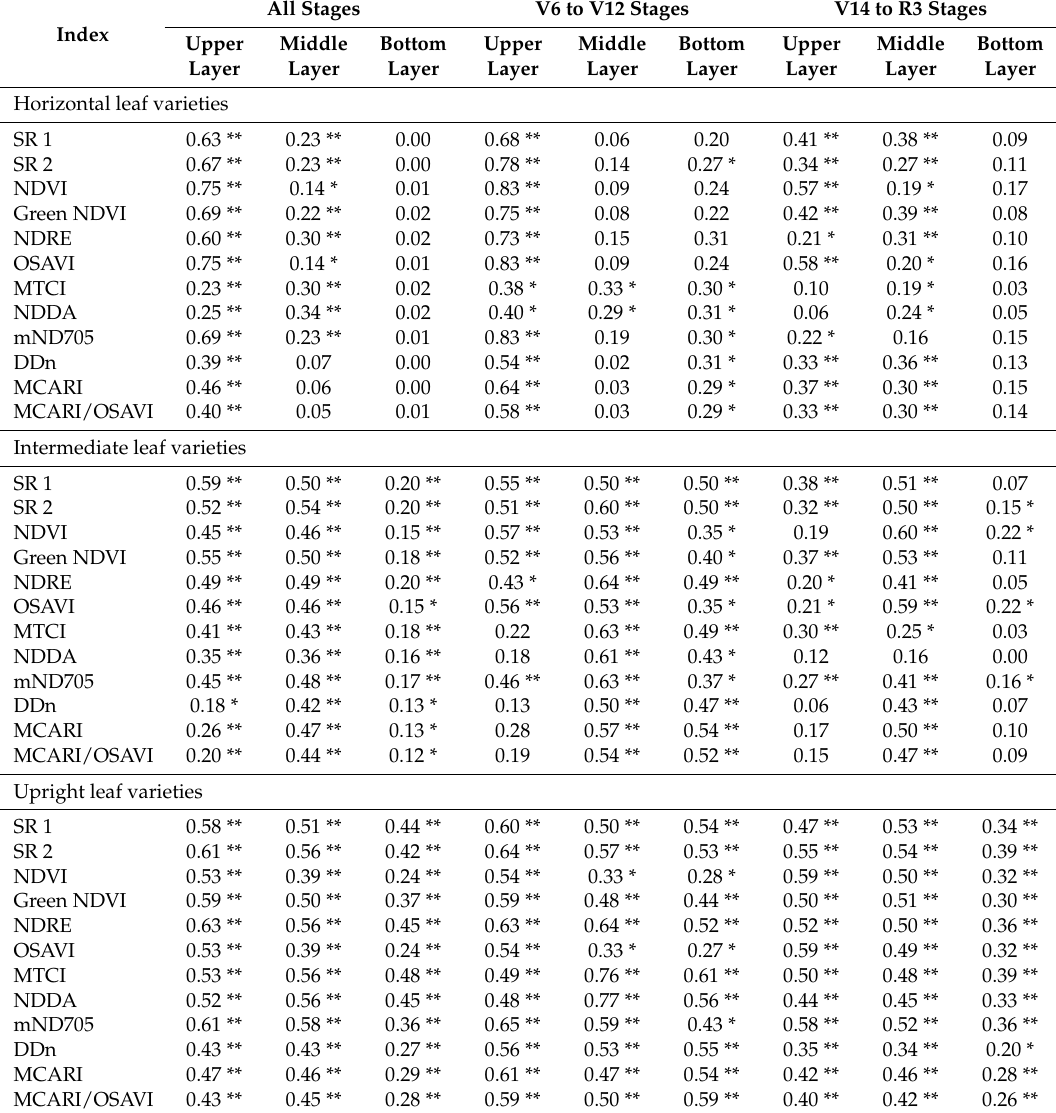
Table 3. Coefficients of determination ( R 2 ) for the relationship between the vegetation indices and the leaf N